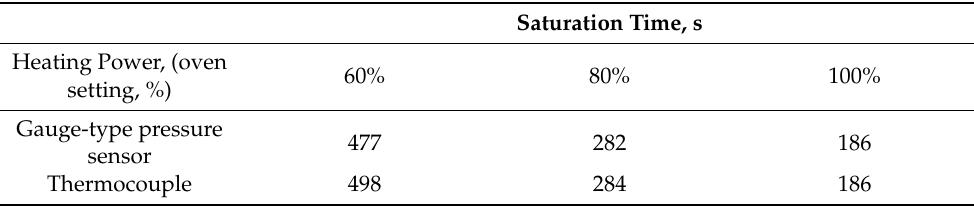
Table 1. Comparison of two different sensors by saturation time